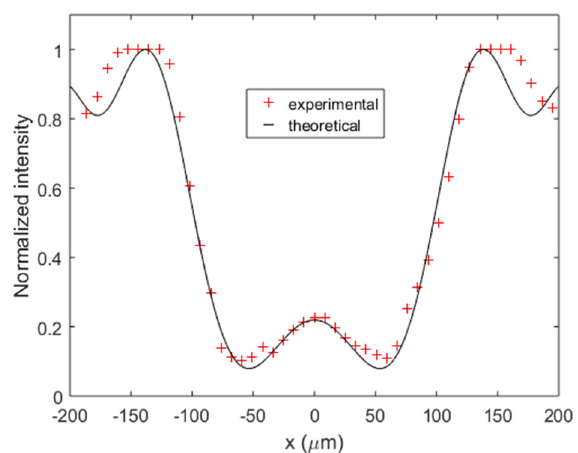
Figure 14. Experimental data and theoretical fit of the intensity recorded on a CCD camera from the diffraction of a hair with a refractive index of 1.55 and a radius of 25.4 µm.